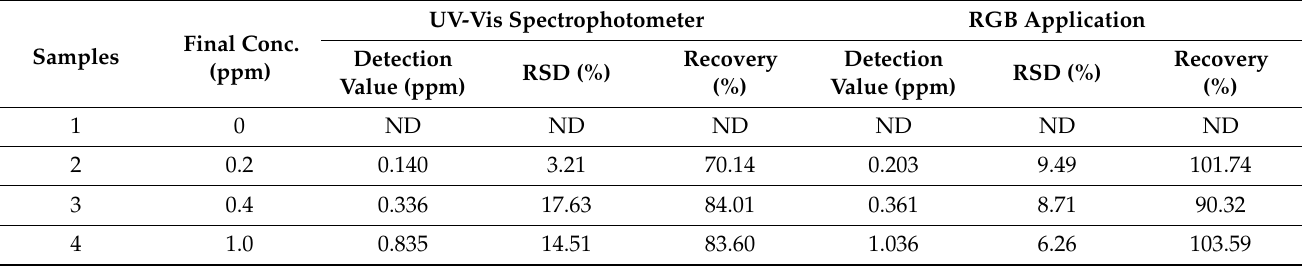
Table 2. Application of the Thy-AuNP-AgNP hybrid sensing probe for Cu 2+ analysis of real water samples on a UV-Vis spectrophotometer and a smartphone-based